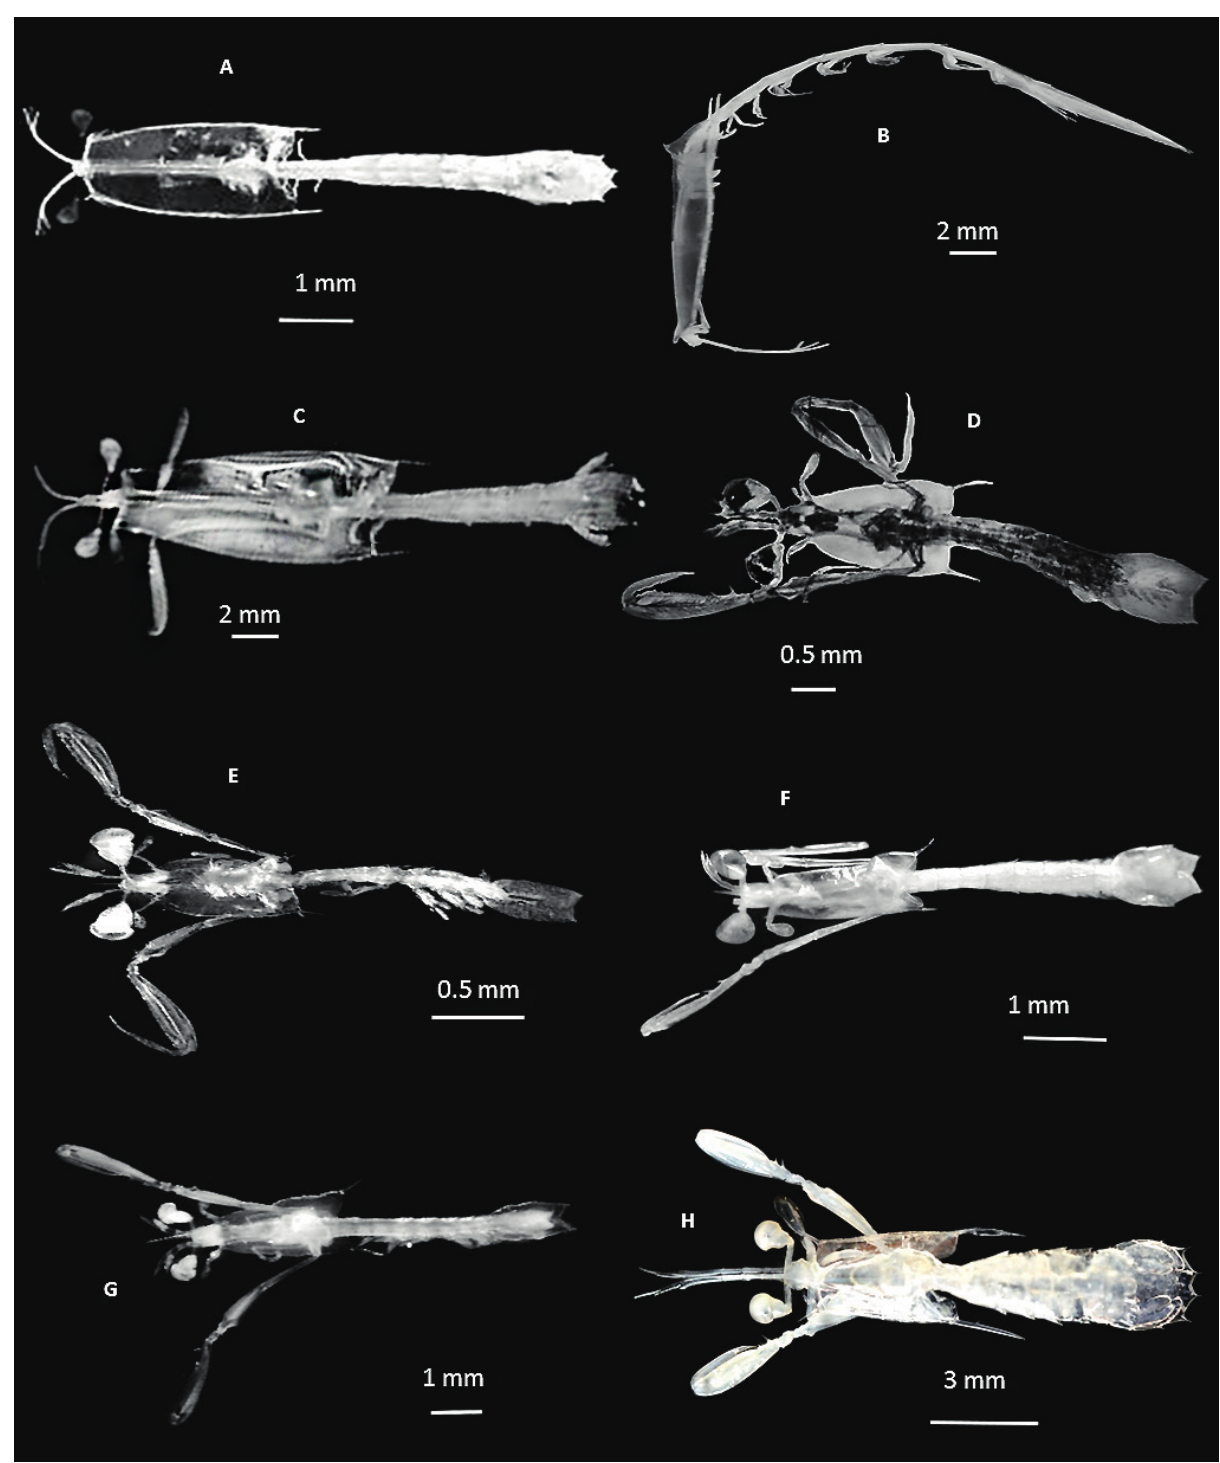
Figure 4. Stomatopod larvae collected at the national parks Sistema Arrecifal Veracruzano (SAVNP) and Arrecife Puerto Morelos (APMNP). A, Alima neptuni (Linnaeus, 1768), stage IV alima; B, A. neptuni stage IX alima; C, Squilla sp. 1, stage IX alima; D, Squilla sp. 2, stage II alima; E, Squilla empusa Say, 1818, stage I alima; F, S. empusa , stage II alima; G, S. empusa , stage III alima; H, S . empusa , stage IX